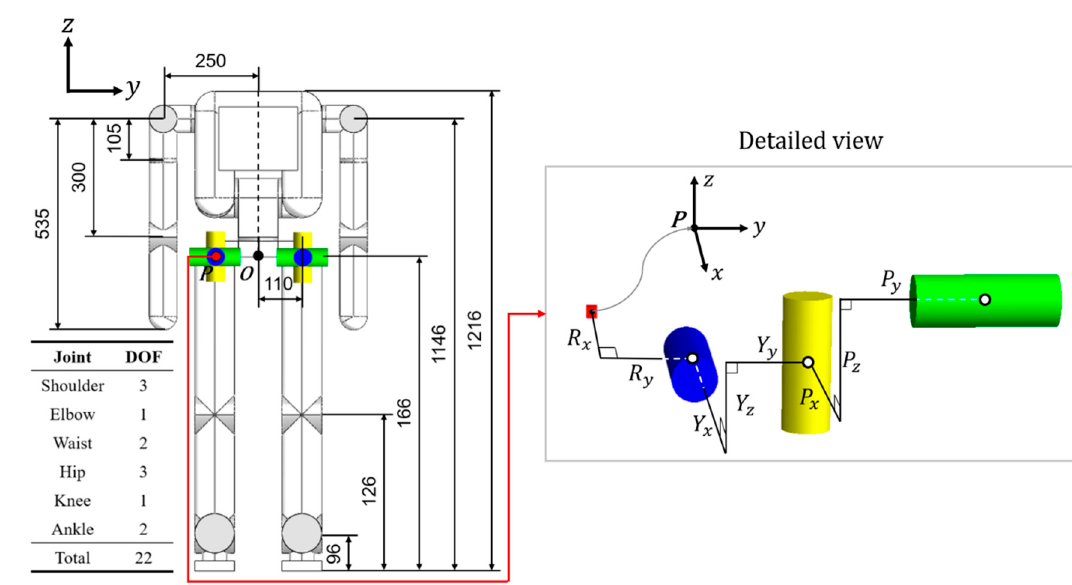
Figure 1. Humanoid robot simulation model (units in millimeters) for optimization. The parameters in the detailed view correspond to joint o ff sets. The design parameters were configured based on the front view of the hip joint for the right leg. The roll, yaw, and pitch joints are represented as blue, yellow, and green colors,